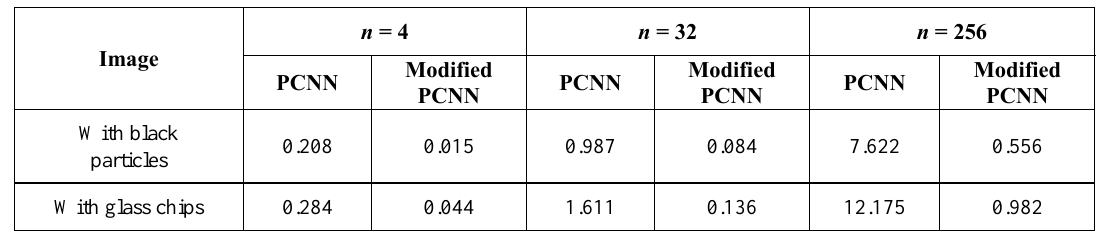
Table 3. PCNN running time (s).